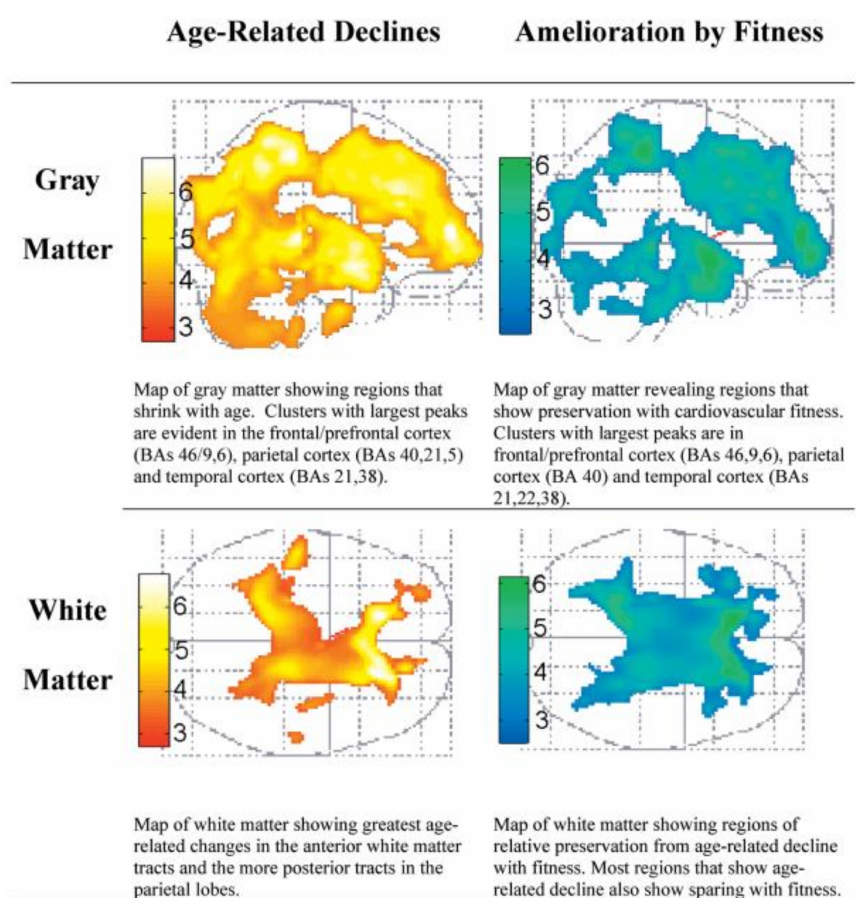
Figure 4. Statistical maps derived from multiple regressions of age and cardiovascular fitness on gray ( top row ) and white matter ( bottom row ) density [214]. The brighter colors represent greater tissue density changes with age ( left side ) and greater sparing of tissue density with increasing fitness ( right side ). Reproduced with permission from Oxford University Press, J Gerontol A Biol Sci Med Sci. 2003. License